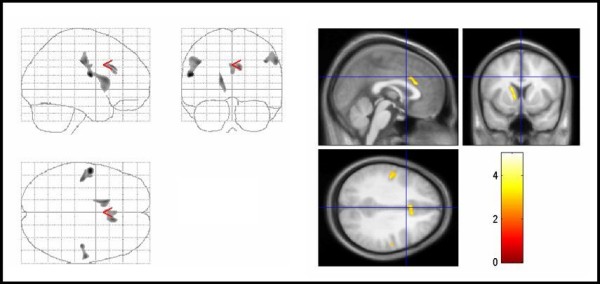
Areas of decreased regional gray matter volumes in TS patients compared with controls (thresholded at uncorrected P < .005 for display purpose only). The three orthogonal planes on the left side represent a typical maximum intensity projection "glass brain", and the set of images on the right side illustrates results superimposed on averaged and normalized T1-weighted images of the study population in selected planes. The images are shown in neurological convention. The color bar represents the t-score. Significant voxels were found in the left caudate nucleus, cingulate gyrus, primary and premotor cortex bilaterally (corrected P < .05). TS = Tourette syndrome.